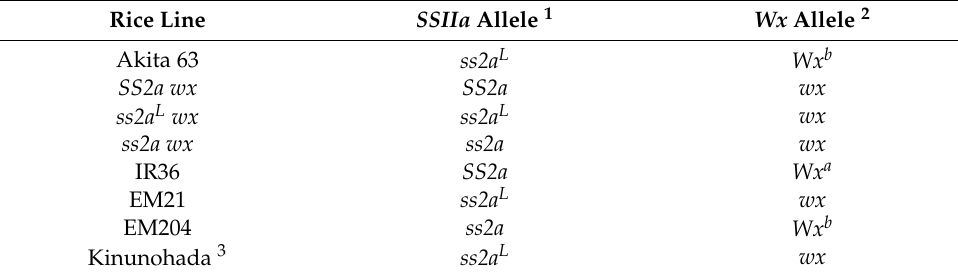
Table 1. Summary of SSIIa and Wx genotypes in rice lines.